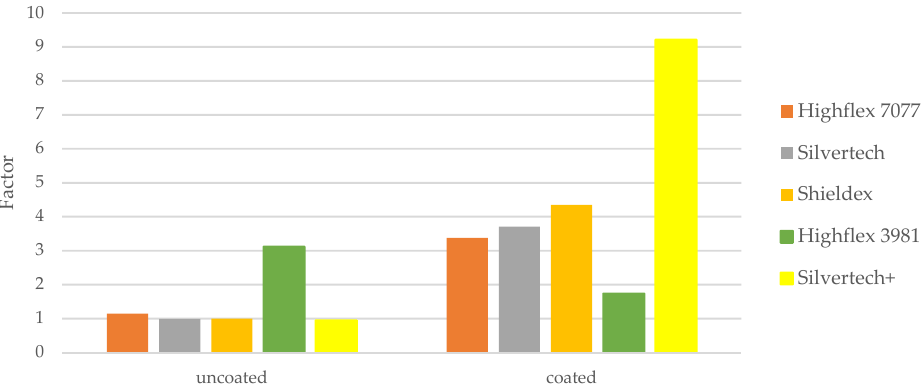
Figure 13. Mean factor of resistance change of all cycles demonstrating the enhancement of sensory properties towards loading by coating.